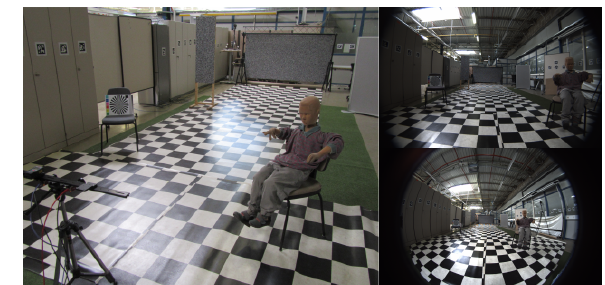
Figure 9. Overview of the experiment (left). Fish eye image (right, bottom) and rectilinear image (right,